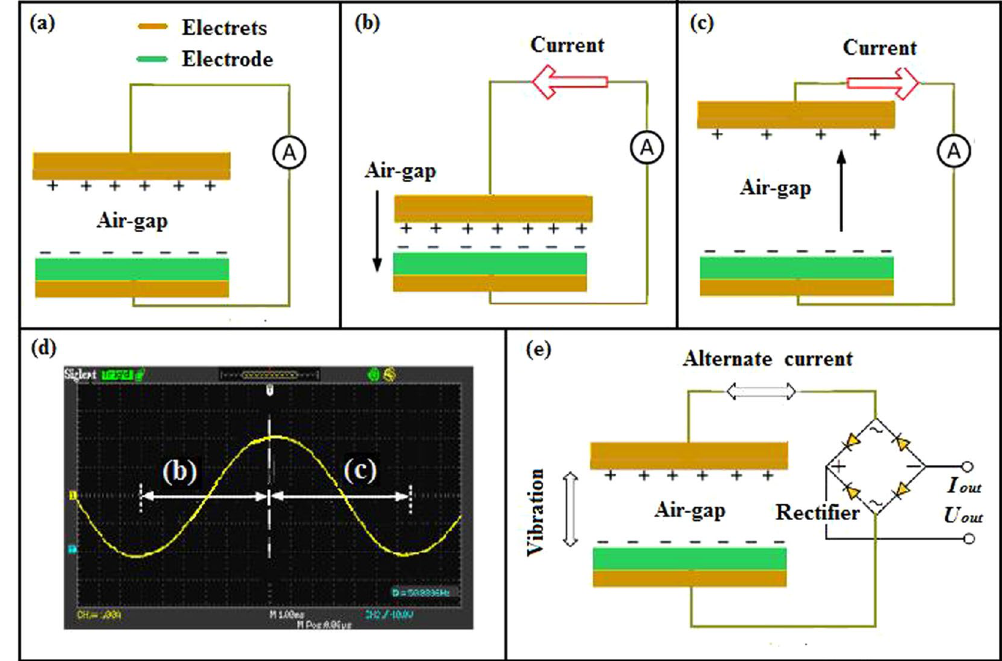
Figure 3. Configuration schematic and current output performance of vertical vibration energy harvester. ( a ) Basic configuration of energy harvester; ( b ) Current output when air-gap is reduced; ( c ) Current output when air-gap is added; ( d ) Waveform of current output corresponding to ( b ) and ( c ) process; ( e ) Entire configuration of vertical vibration energy harvester.